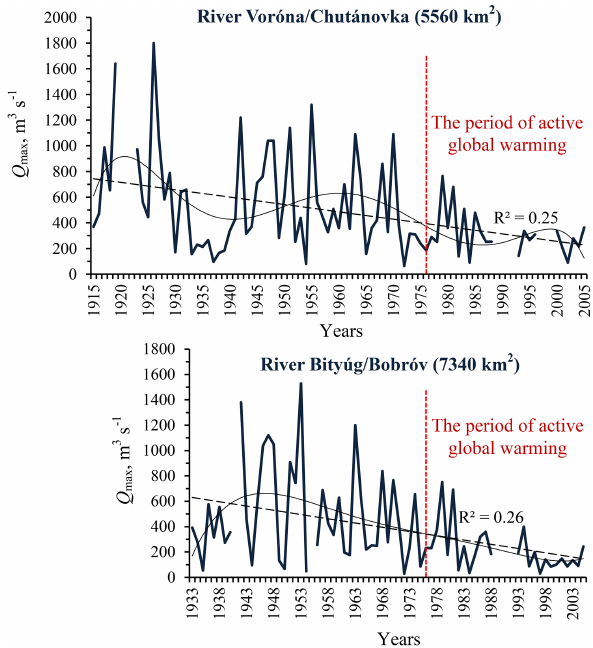
Figure 2. Trends in maximum water discharges ( Q max ) during spring floods for some small rivers in the south of the forest-steppe zone of the